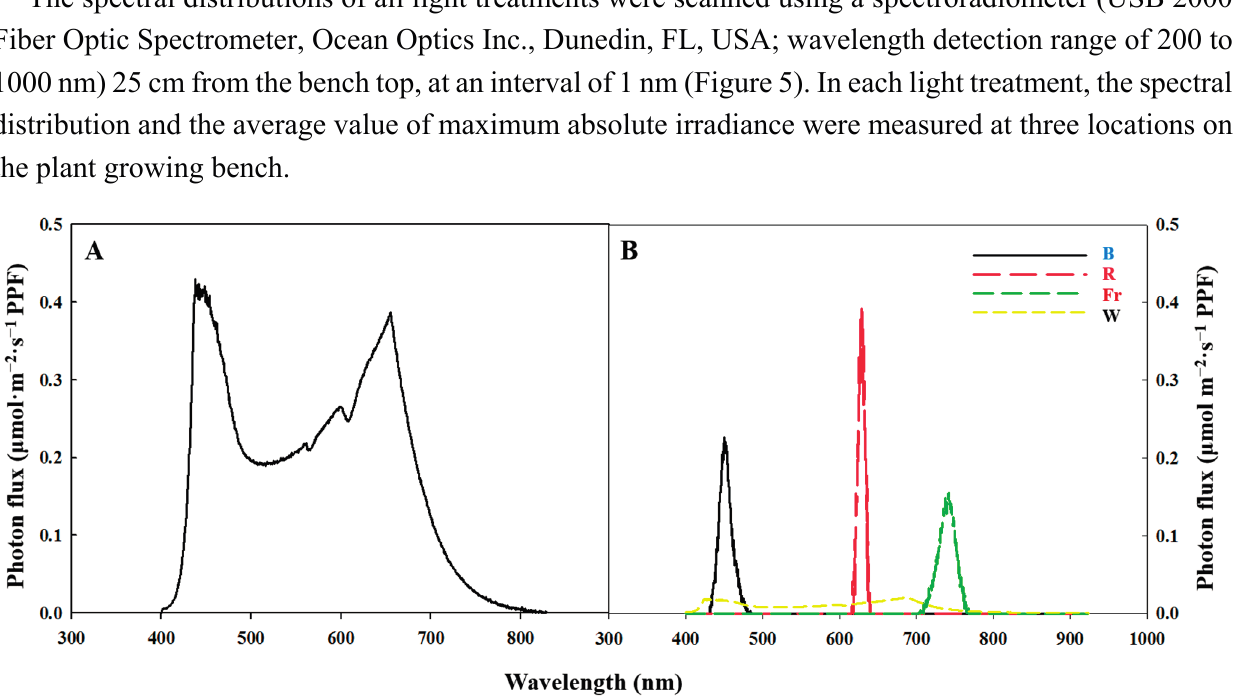
Figure 5. Spectral distribution of light used in a closed walk-in growth chamber: white light emitting diodes (LEDs) used as daily light ( A ) and different LEDs (B, blue; R, red; Fr, far-red; and W, white) used as light of night interruption (NI) ( B